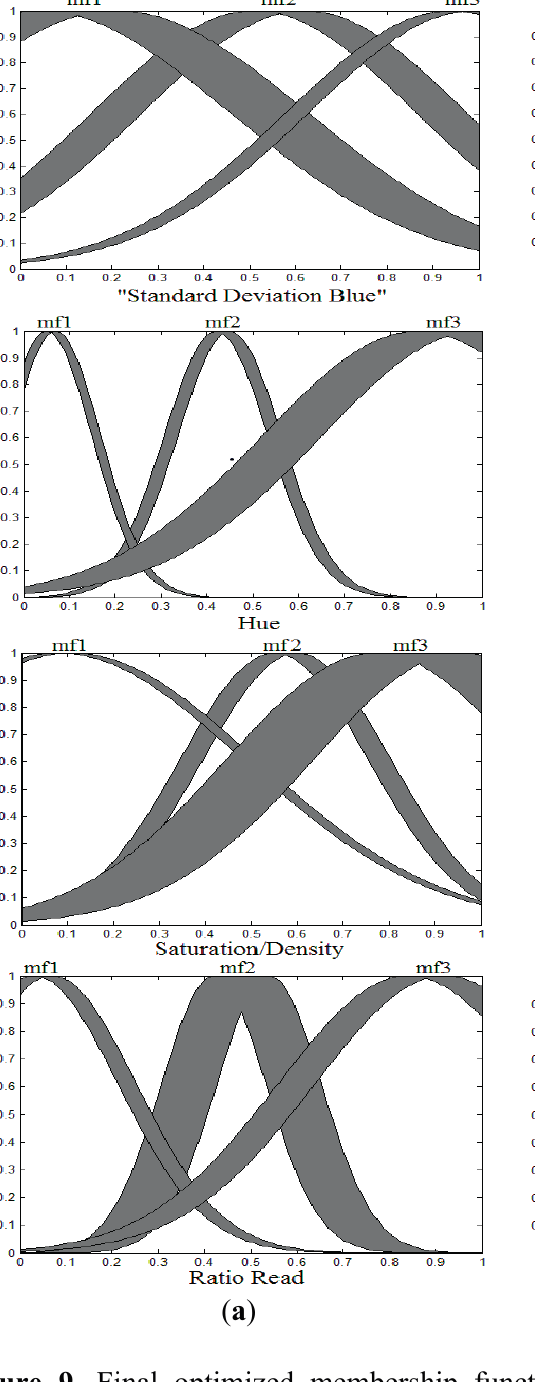
Figure 9. Final optimized membership function for input features: ( a ) T2 optimized membership function; ( b ) T1 optimized membership function; standard deviation blue, hue, saturation/density and ratio red respectively in the